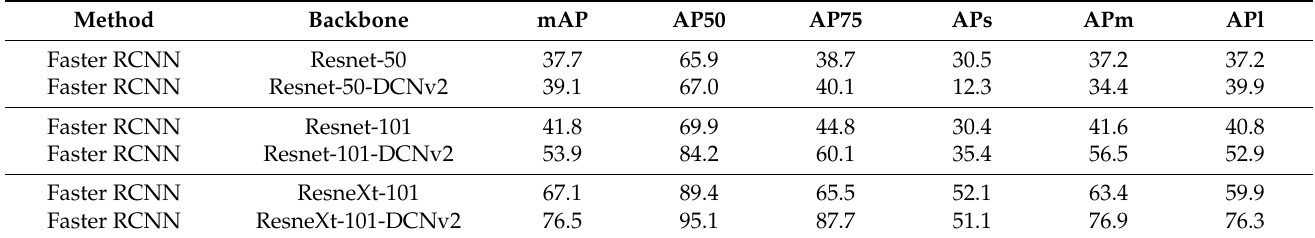
Table 6. Ablation Studies of Deformable